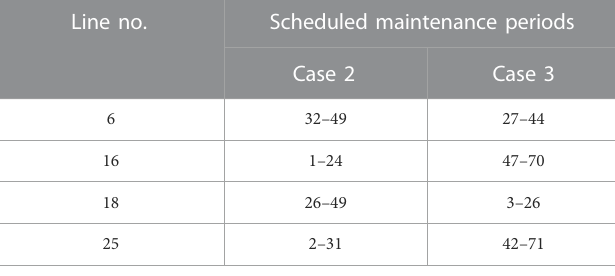
TABLE 2 Scheduled transmission maintenance periods in case 2 and case 3. Line no.